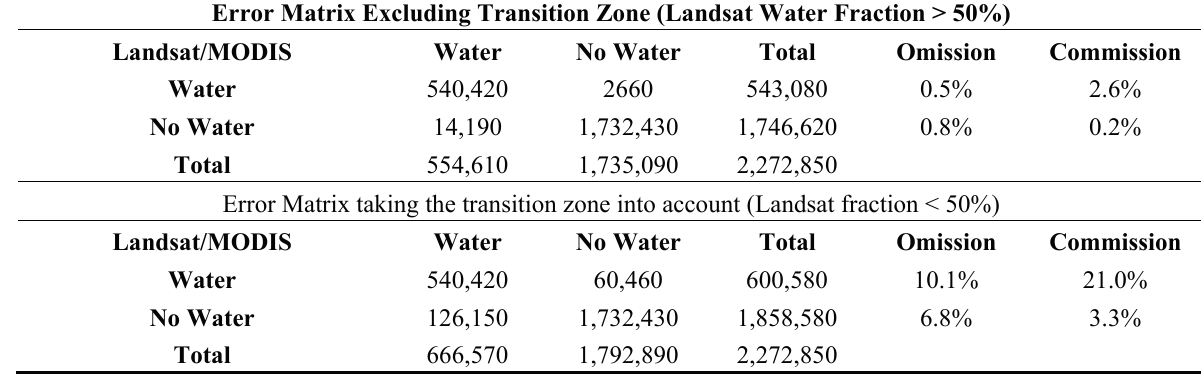
Table 3. Accuracy tables for the Ganges Delta, year 2013, day of the year 310. Error Matrix Excluding Transition Zone (Landsat Water Fraction > 50%)